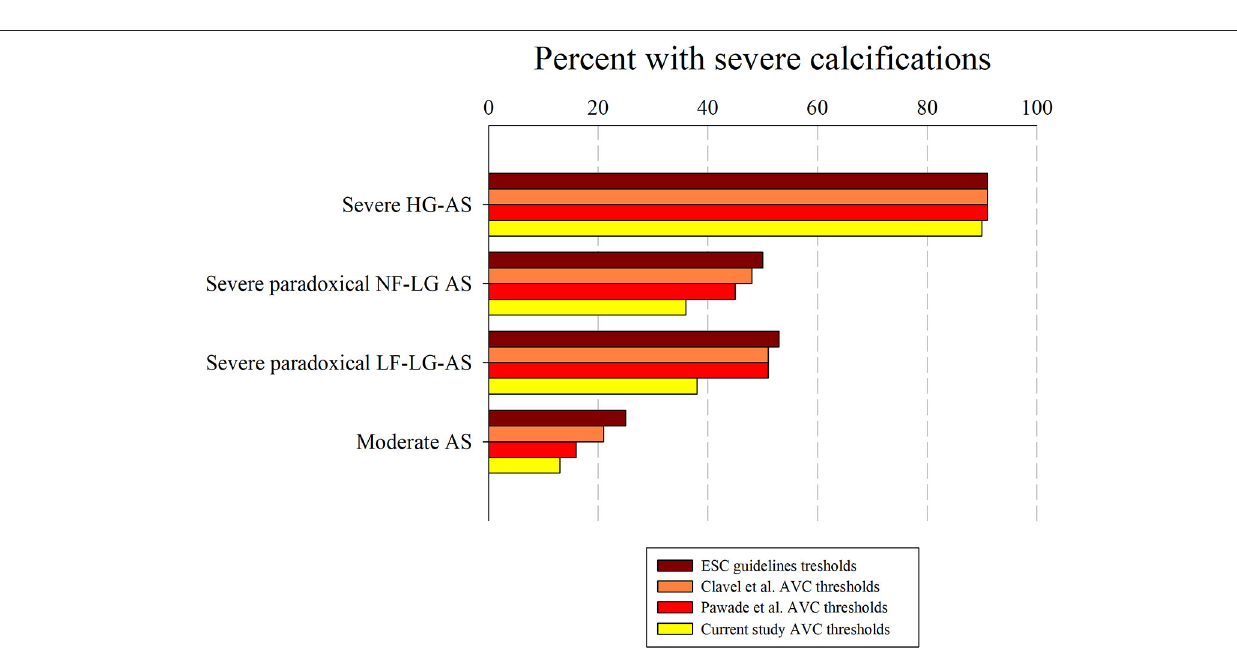
FIGURE 7 | Percent of patients with high AVC load in the different AS severity groups. Percent of patients with high Agatston score according to current thresholds, guidelines thresholds, Clavel’s thresholds and Pawade’s in subgroups with severe HG-AS, severe paradoxical normal flow (NF) or low flow (LF) LG-AS and moderate